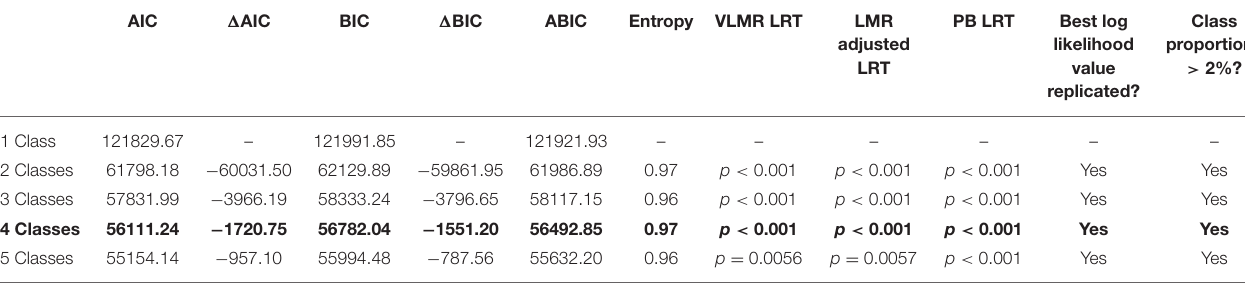
TABLE 1 | Model fit information of latent class